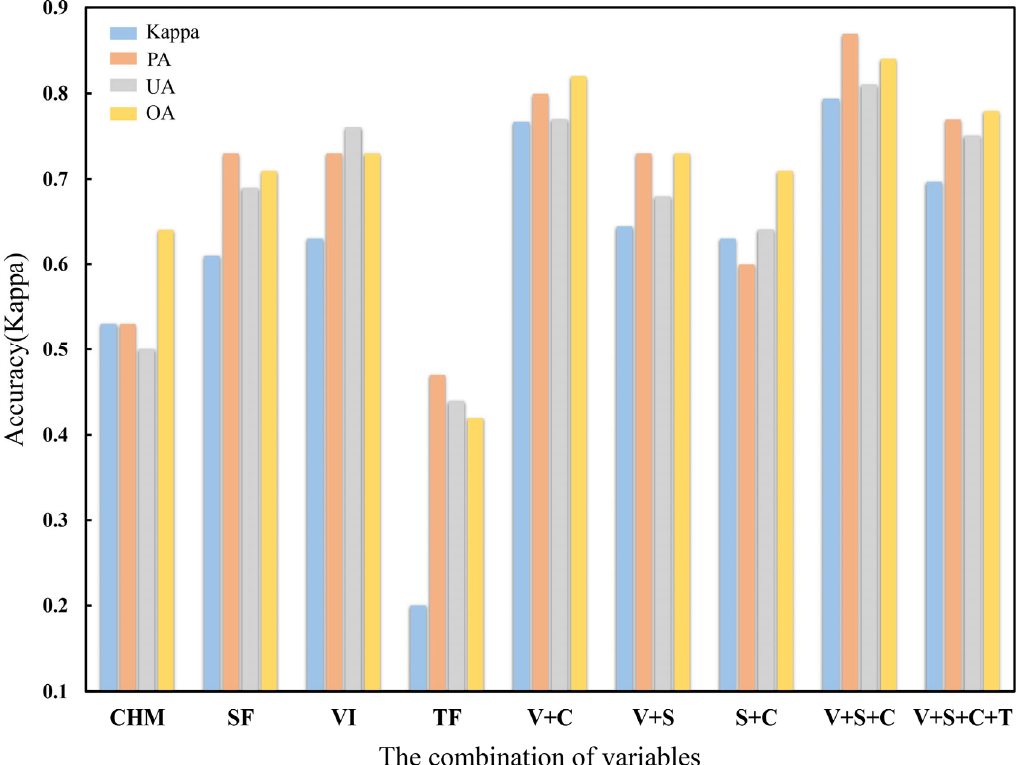
Figure 4. Accuracy assessment of tree ‐ species classification with different combinations of variables.